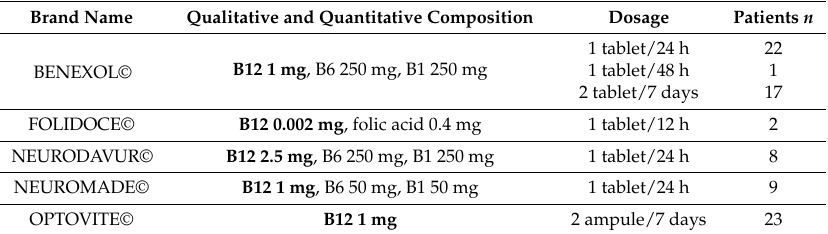
Table 3. Vitamin B12 oral treatment regimens used for maintenance